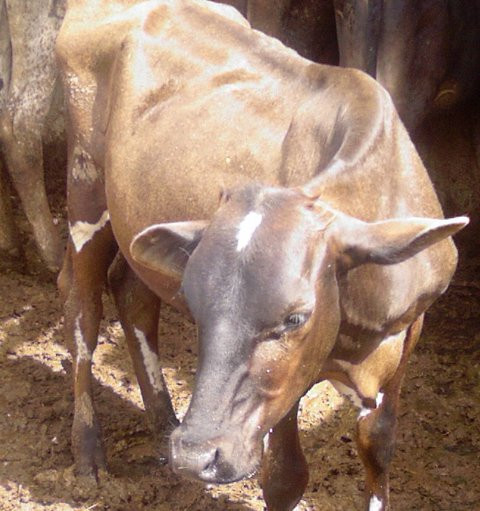
Cattle (Bos taurus).